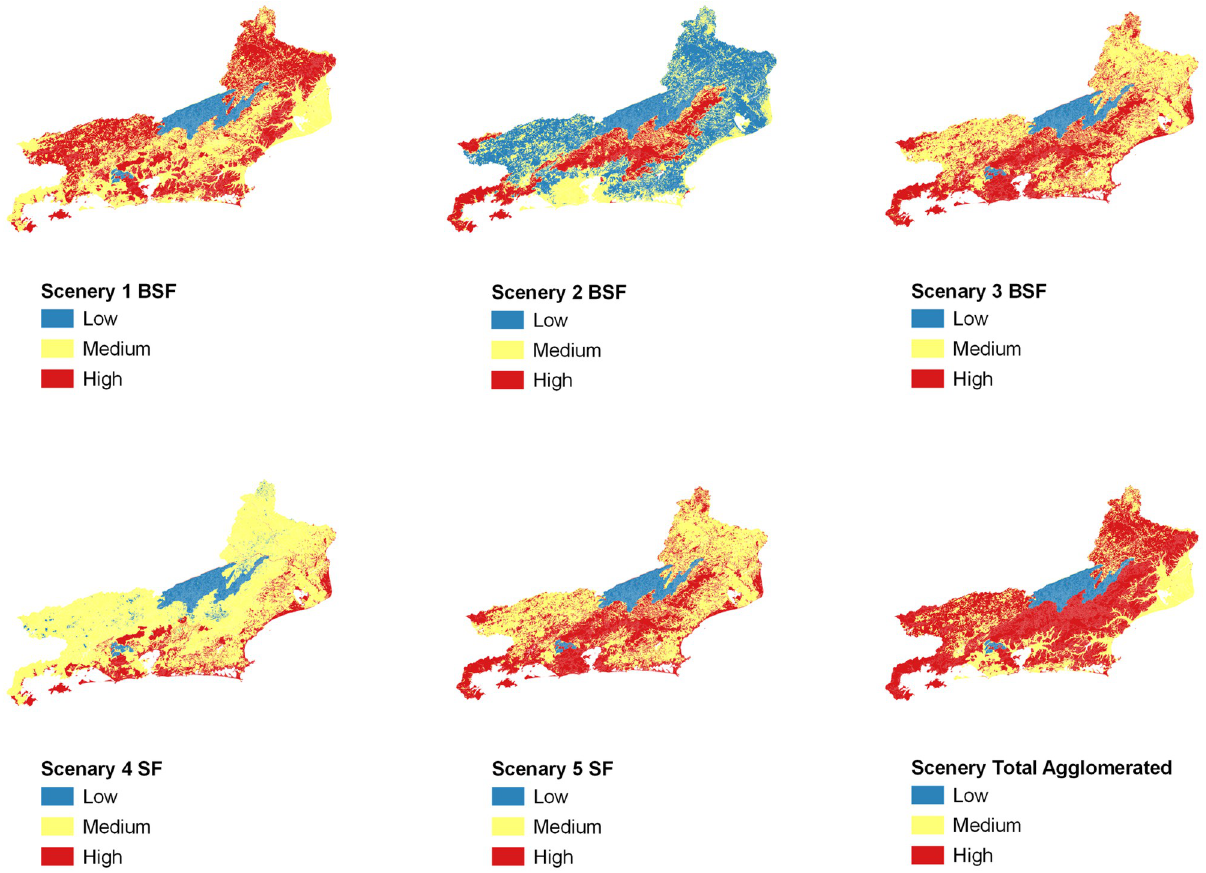
Fig 3. Spotted fever rickettsiosis potential risk map to Rio de Janeiro state, Brazil due to ecological relationships between hosts and vectors. Scenery 1 (BSF); Scenery 2 (BSF); Scenery 3 (BSF); Scenery 4 (SF); Scenery 5 (SF); Scenery Total Agglomerated; Three colours’ scale: blue colours—low potential risk; yellow colours—medium potential risk; red colours—high potential